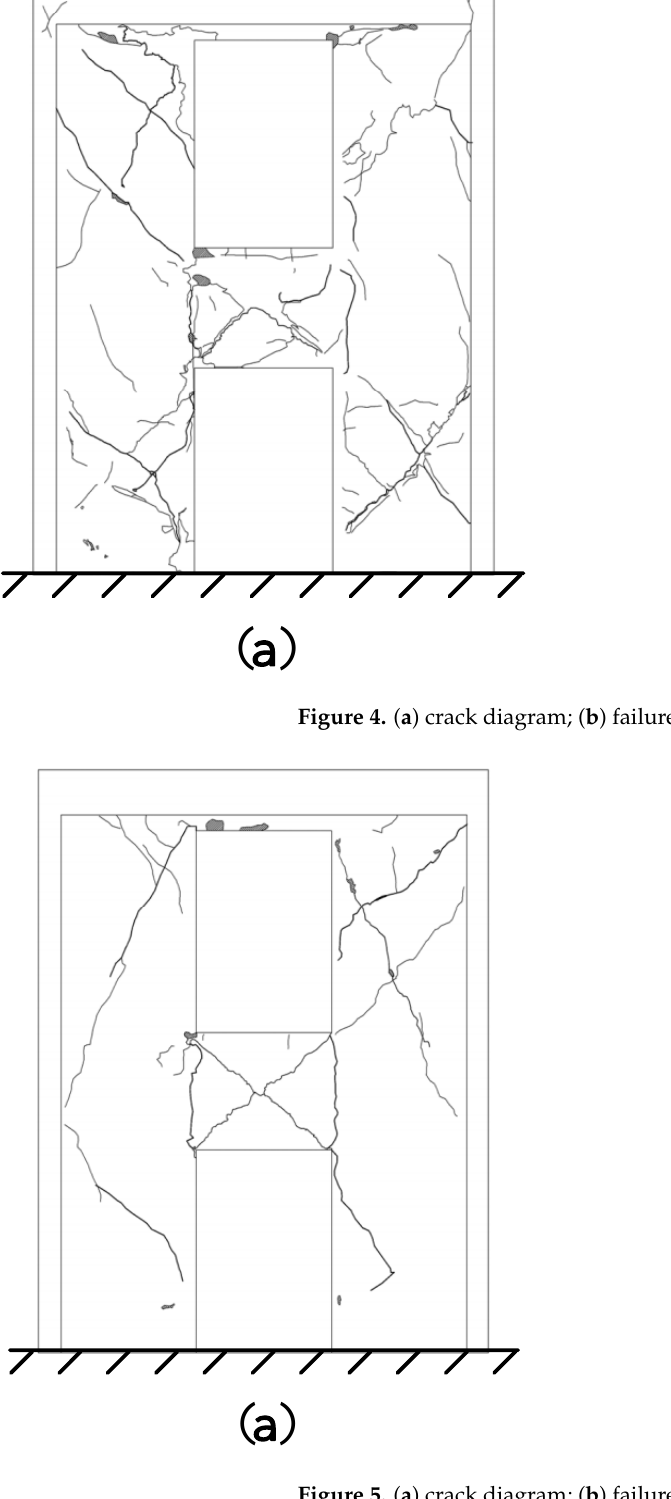
Figure 5. ( a ) crack diagram; ( b ) failure mode of A2